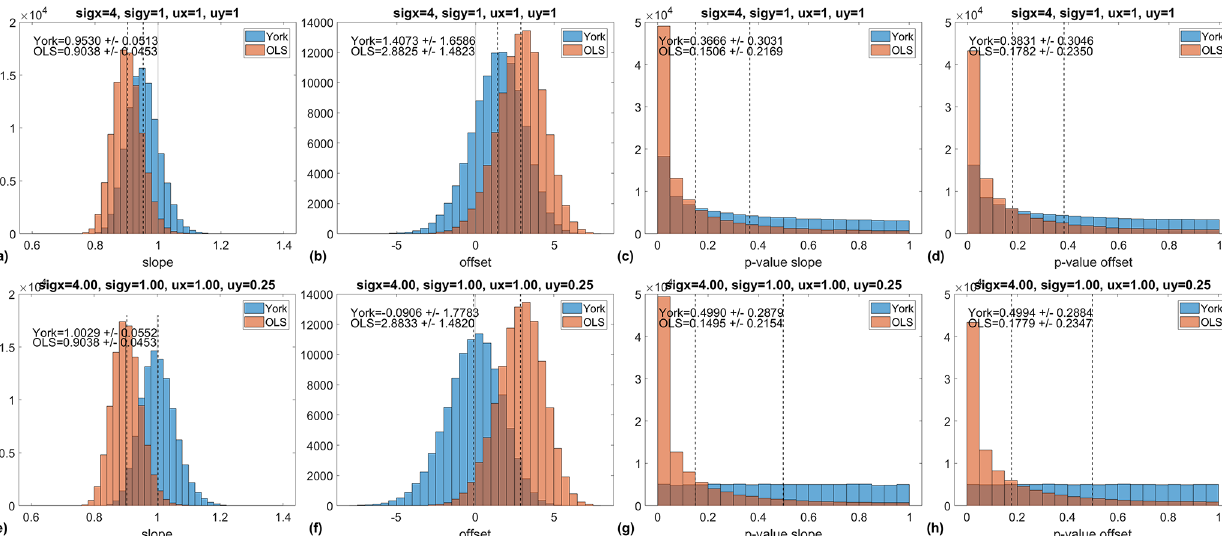
Figure C1. Monte Carlo tests of linear regression using the ordinary least-squares (OLS) and the York et al. (2004) methods. The plots show the distributions of slope, offset, and respective p values from the hypothesis tests ( H 0 : slope equal to 1; H 0 : offset equal to zero). The dotted vertical lines indicate the mean values. Mean and standard deviation are reported in each plot. The true slope is 1, and the true offset is 0. Panels (a) – (d) correspond to case no. 5 from Table C1, and panels (e) – (h) correspond to case no. 7. Each case is computed from 10 5 simulations (see Appendix C for further